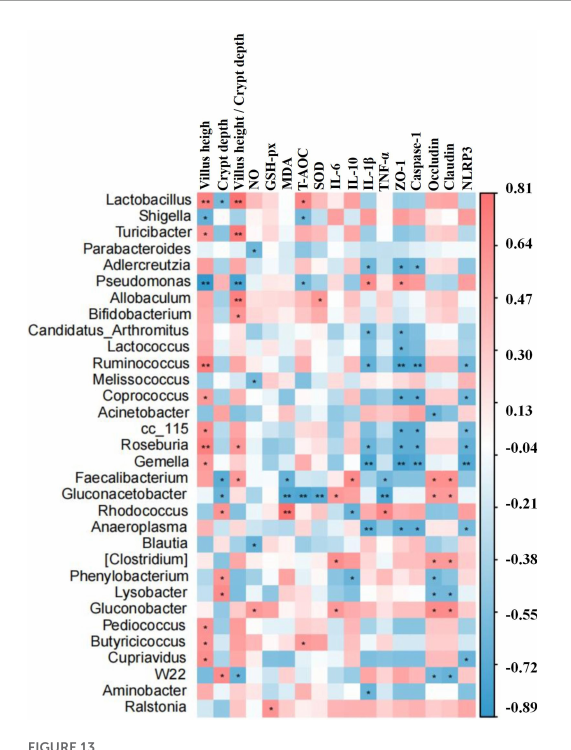
FIGURE13 The differential bacteria of mouse were notably corrected with the indices of inflammatory cytokines, oxidative status, intestine morphology, and gene expressions by the statistical analysis system. Significance is presented as * p < 0.05 and ** p < 0.01; data are presented as the mean ± SEM ( n =